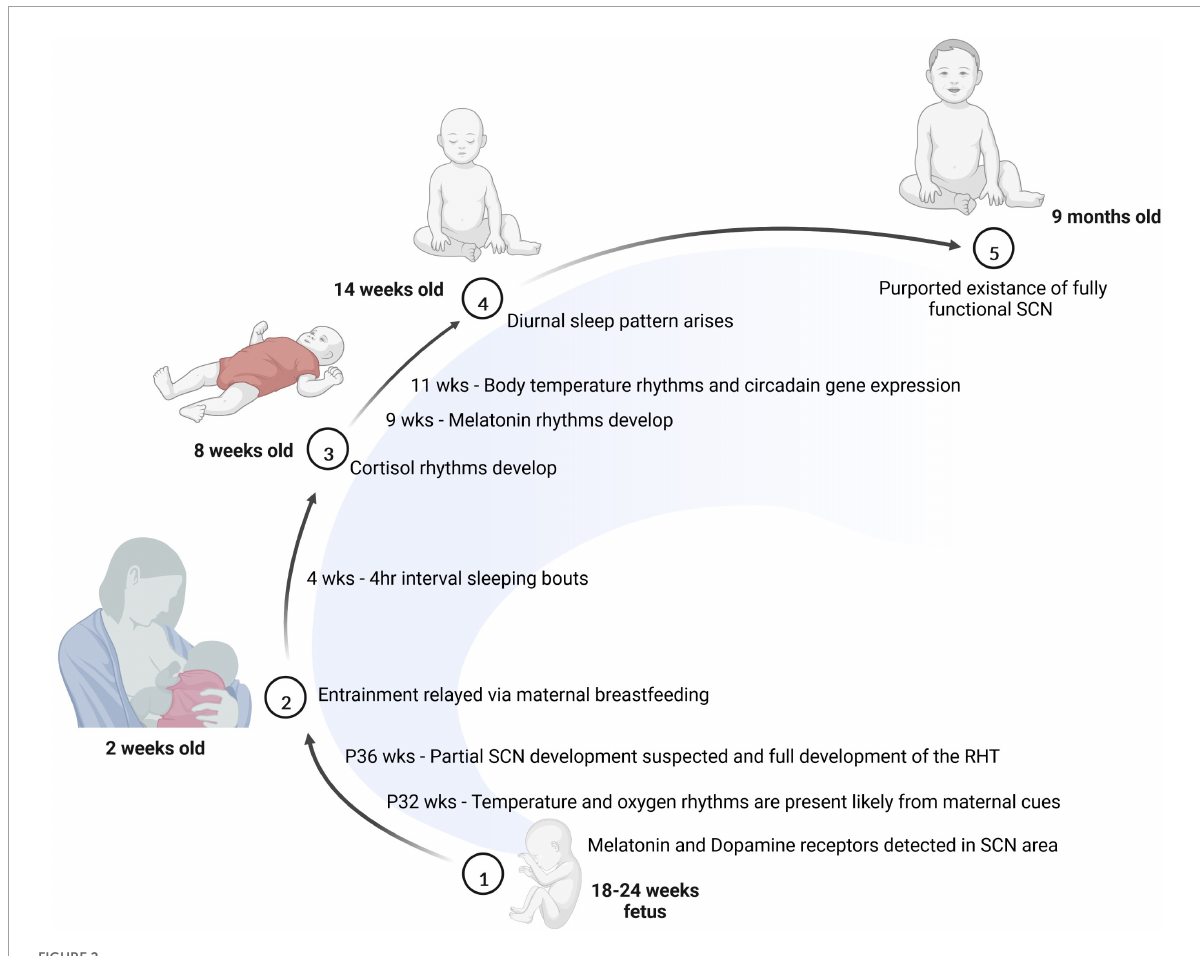
FIGURE2 The development of the circadian system is initiated prior to birth. Between 18 and 24 weeks of age, melatonin and dopamine receptors are detectable in the SCN. Soon after birth, many entrainment cues are passed to the baby through breast milk. At 8 weeks of age, cortisol rhythms have emerged in the infant, and by 14 weeks of age, most babies show a diurnal sleep pattern. Finally, at 9 months of age, the baby is thought to have a fully functional